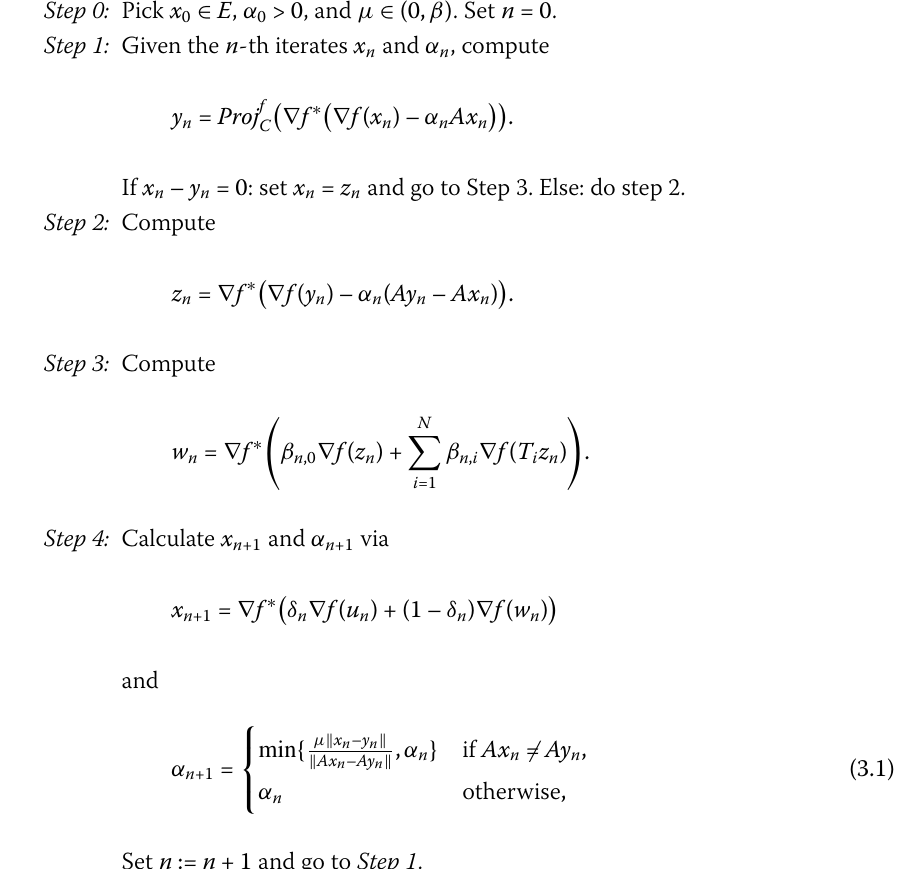
Algorithm 1: A self-adaptive Tseng extragradient method with Bregman distance (Alg.